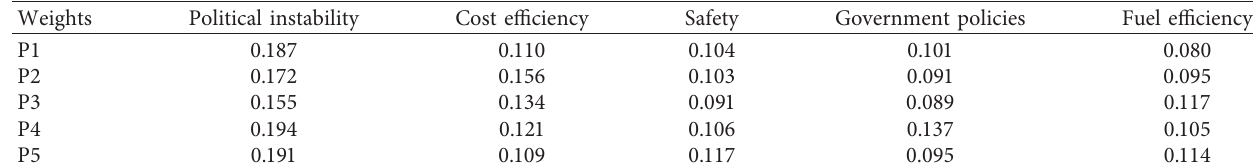
Table 12: Sets of weights used for sensitivity analysis.